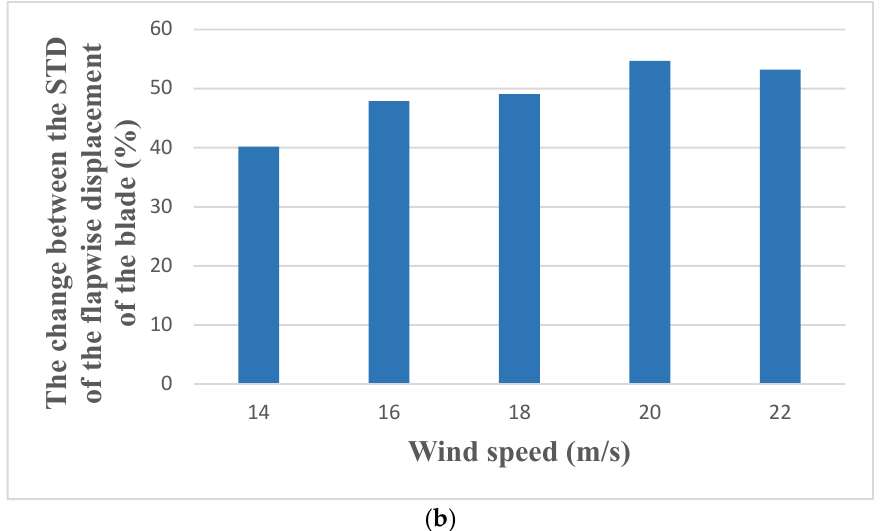
Figure 14. The difference between the STD of the vibration loads of the coupled model and the uncoupled model. ( a ) fore-aft displacement of the nacelle ( b ) flapwise tip displacement of the blade.